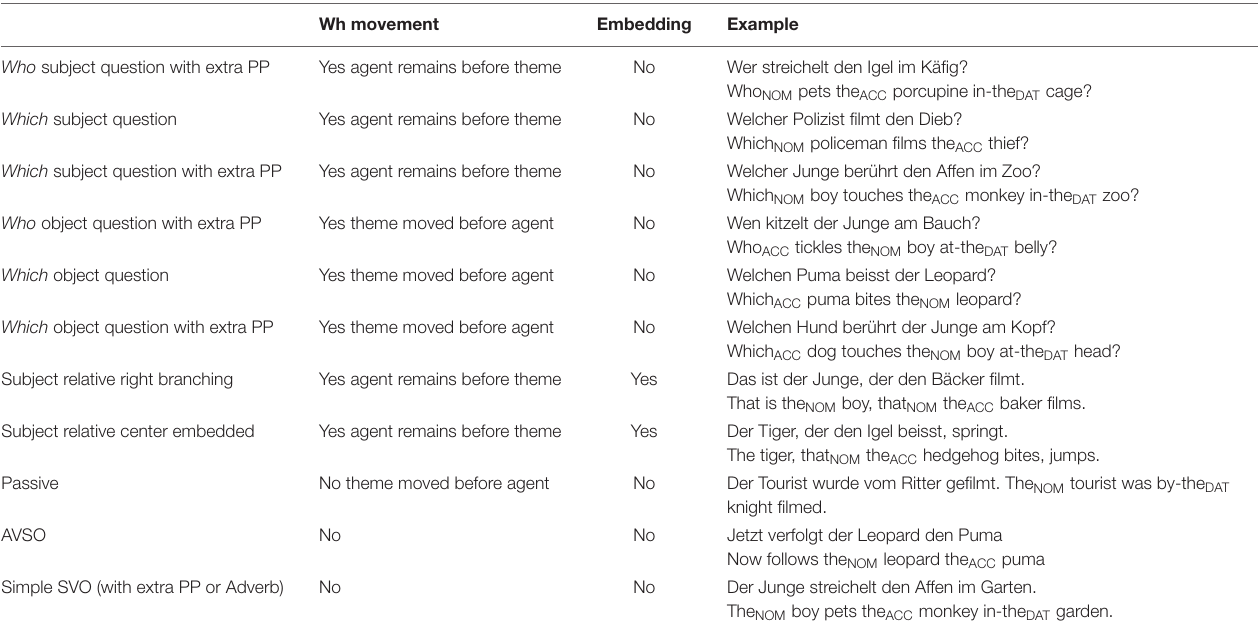
TABLE 4 | Types of sentences included in the repetition